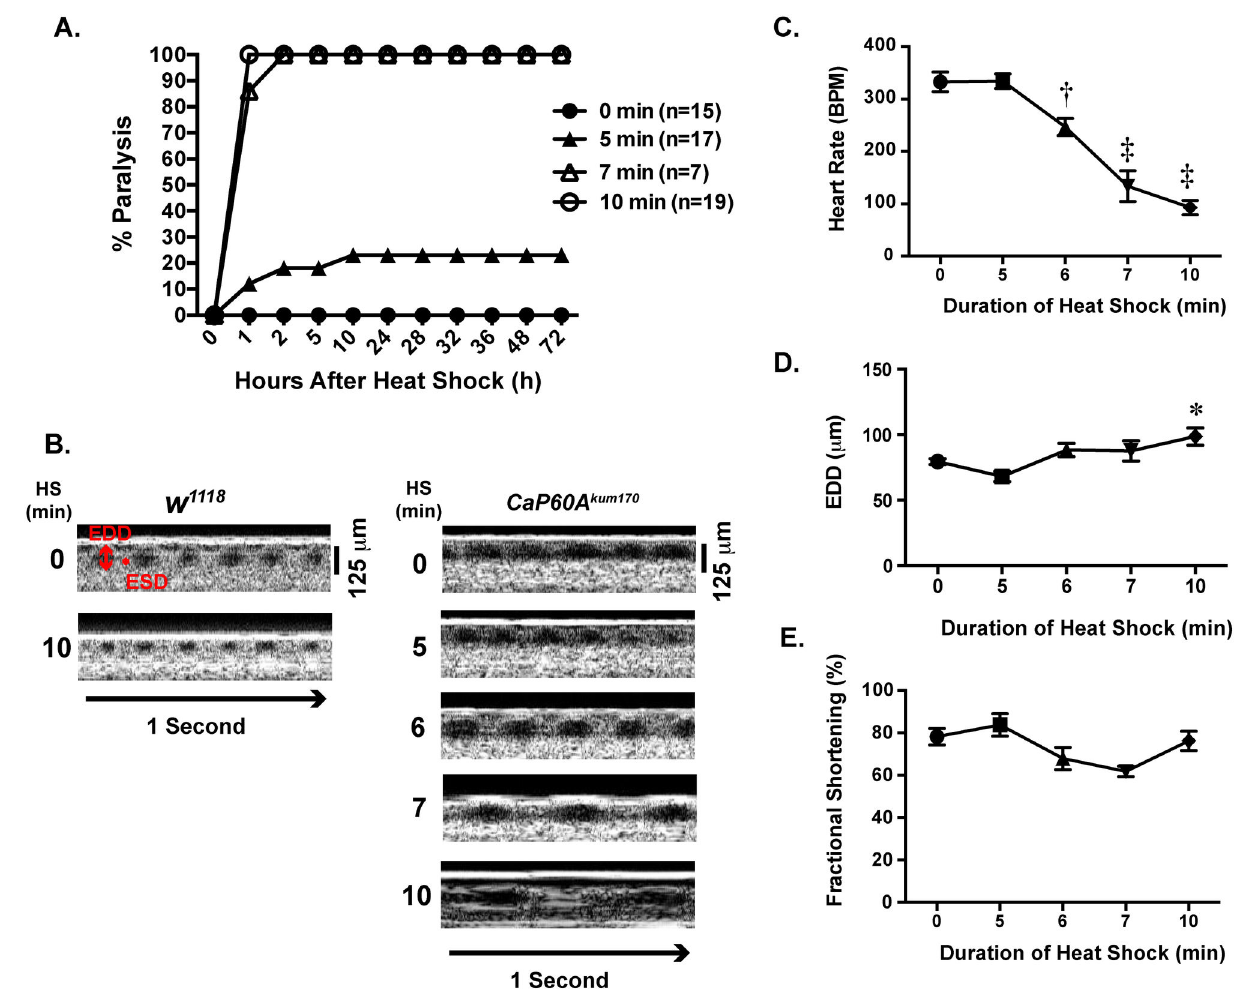
Figure 1. CaP60A kum170 mutant has altered heart rate and cardiac dimensions after heat shock. A . Percent paralysis after heat shock. CaP60A kum170 heterozygote flies were exposed to heat shock of varying durations (no heat shock defined as 0 min (closed circle), 5 min (closed triangles), 7 min (open triangles), or 10 min (open circles)) and observed for up to 72 hours. All flies receiving a heat shock of greater than 7 minutes developed irreversible paralysis; while a smaller percentage of flies developed paralysis after 5-minute heat shock. B . Representative optical coherence tomography (OCT) recordings from w 1118 and CaP60A kum170 after varying durations of heat shock (HS). End diastolic dimension (EDD) and end systolic dimension (ESD) are denoted in red; A 125 micron standard and one-second bar are shown. C . Heart rates measured from 3 second OCT recordings show a progressive decline in heart rate with increasing durations of heat shock. D . End diastolic dimensions (EDDs) increase with increasing duration of heat shock. E . Fractional shortening is not markedly altered with heat shock in the CaP60A kum170 mutants. *p<0.05, † p<0.005, ‡p<0.0001 in comparison to 0 minutes heat shock by one-way ANOVA with Tukey’s multiple comparisons test. N= 16, 12, 16, 4, 22 for 0, 5, 6, 7 and 10 minute groups,